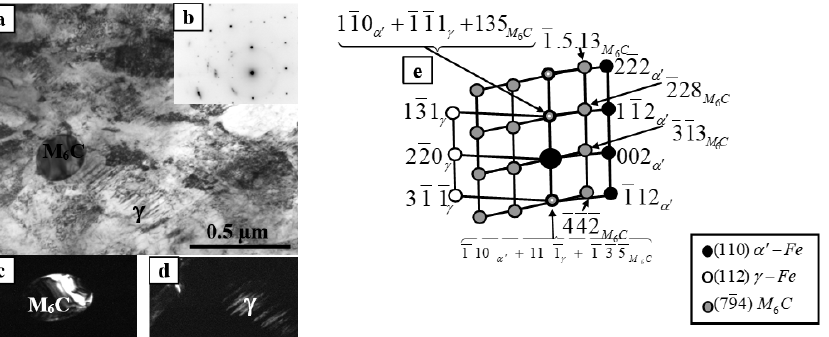
Figure 6. TEM—images of residual austenite and carbide in steel R6M5 after impact by an electron beam ( a )—bright-field image; ( b )—microdiffraction pattern; ( c )—a dark-field of M 6 C carbide; ( d )— the dark-field image of residual austenite; ( e )—the indicated microdiffraction pattern.